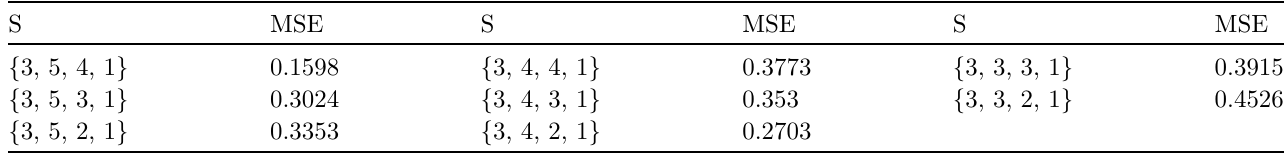
Table 7. ANN algorithm: